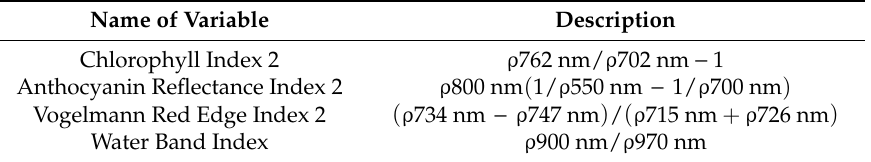
Figure 3. Spectral characteristic curves of six land cover types in the study area. Table 2. Description of spectral indexes used in this study.